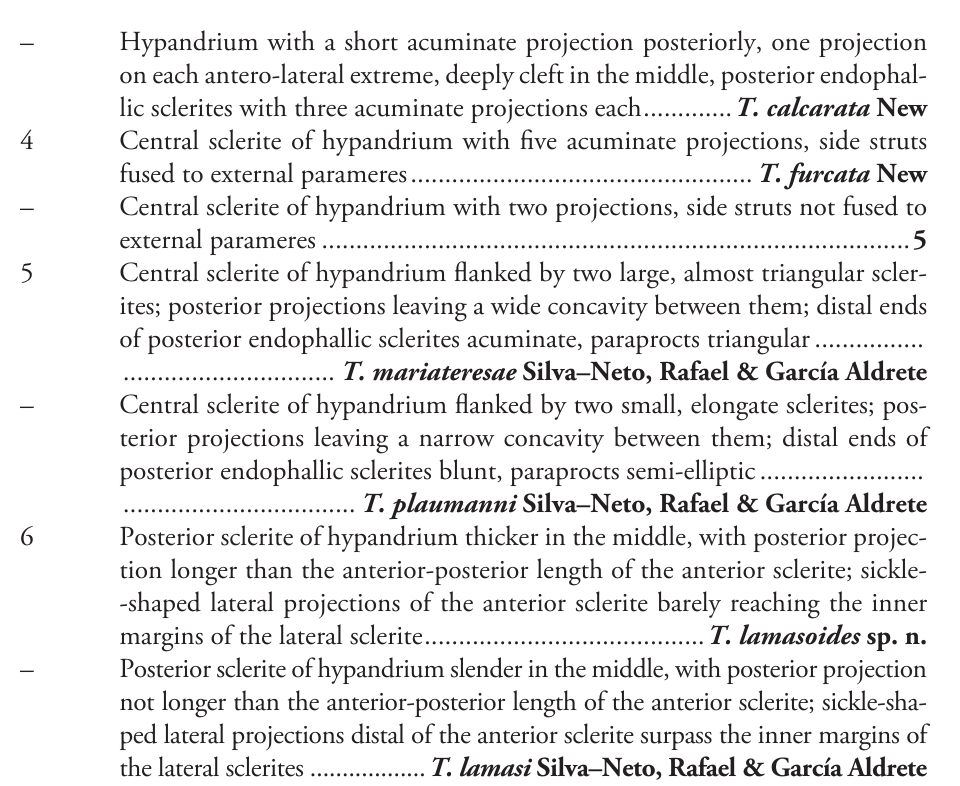
the lateral sclerites .................. T. lamasi Silva–Neto, Rafael & García